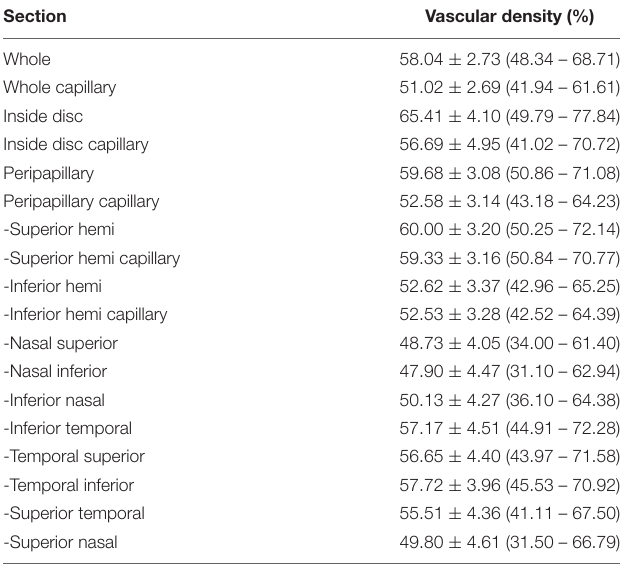
TABLE 6 | The corrected disc and peripapillary vascular density of normal eyes in children with 4.5 mm × 4.5-mm scan pattern. [Mean ± standard deviation